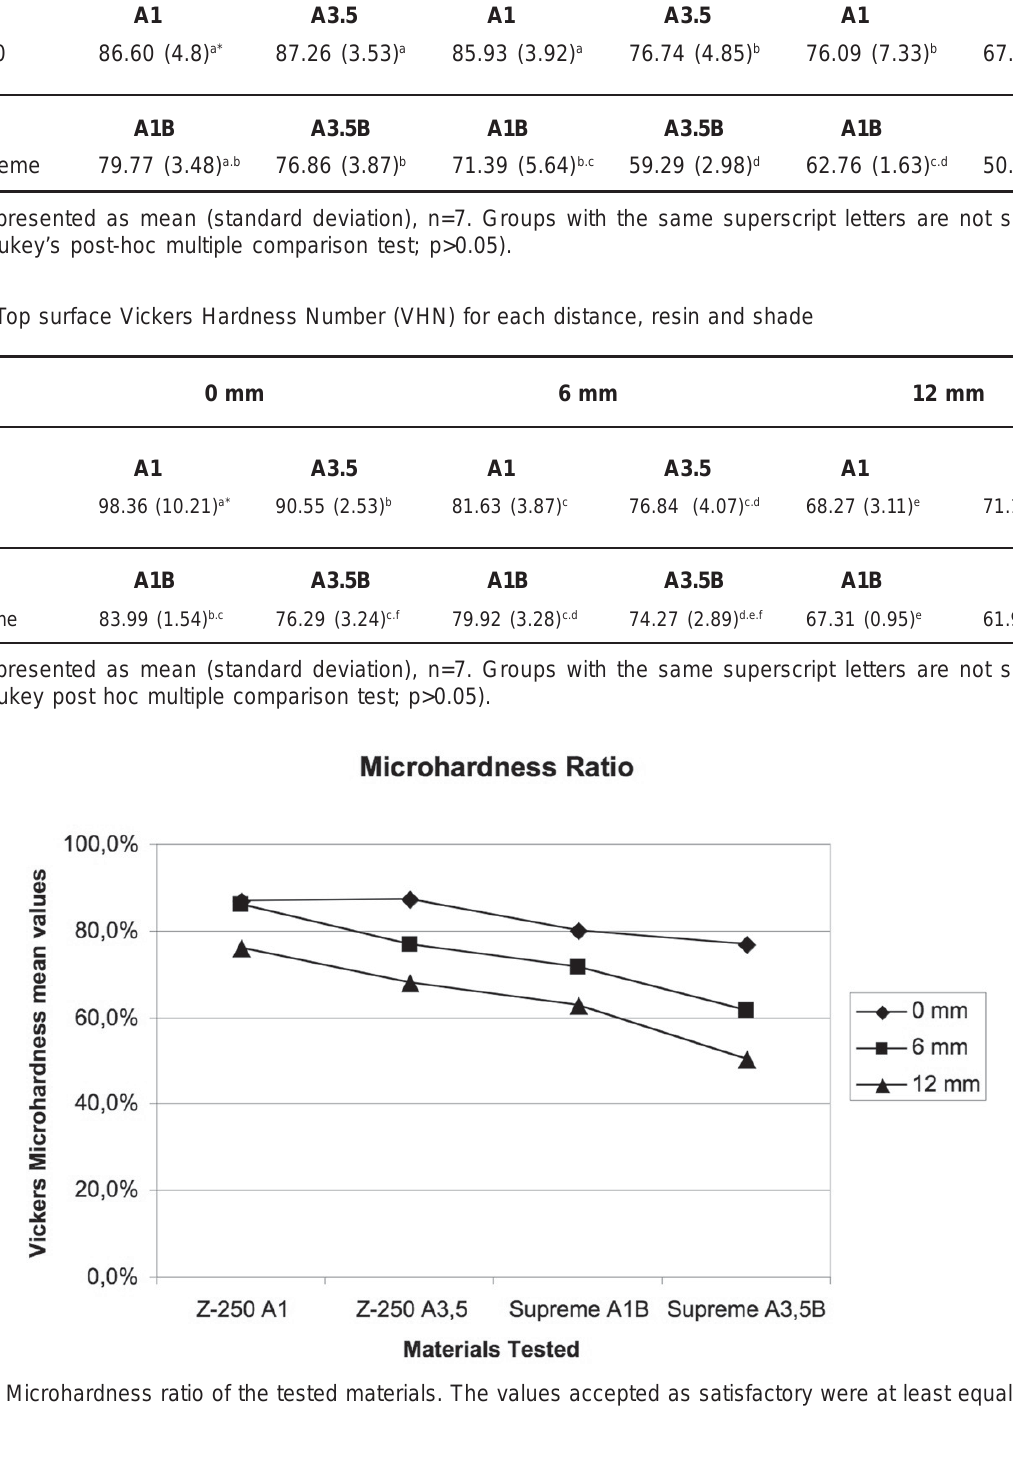
TABLE 2- Microhardness ratio (%) for each distance, resin and shade